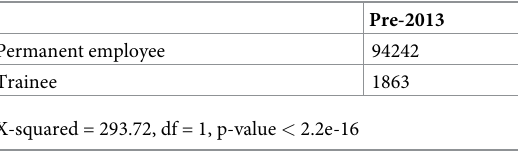
Table 1. Analysis of hiring trends for number of permanent and trainee employees before and after 2013 imple- mentation of the pathways